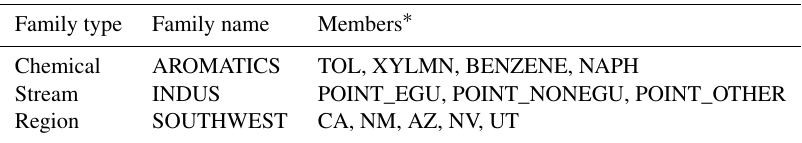
Table 6. Examples of families supported by